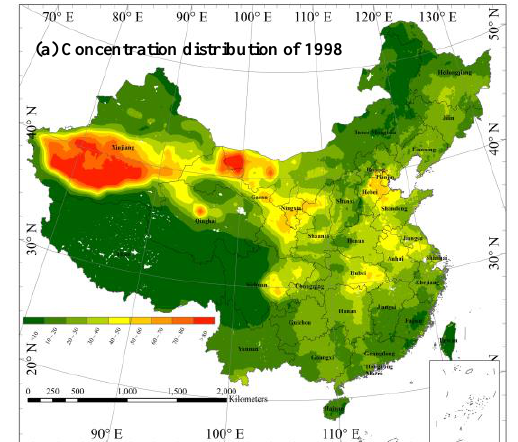
Fig.2. Spatial distribution of annual PM 2.5 concentration in 1998(a) and 2017(b), and distribution of variation concentration between 1998 and 2017